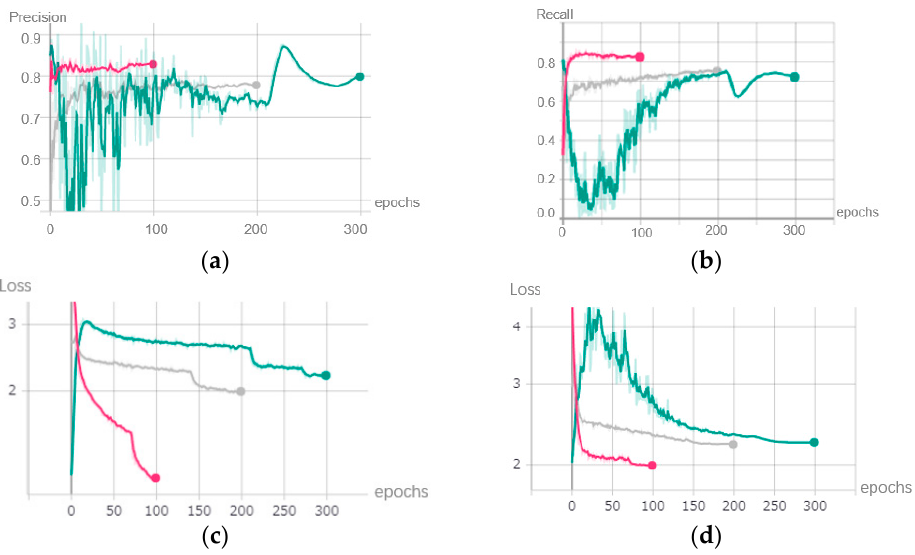
Figure 12. Metrics after fine-tune stage. ( a ) Precision. ( b ) Recall. ( c ) Loss value of training dataset. ( d ) Loss value of testing dataset.